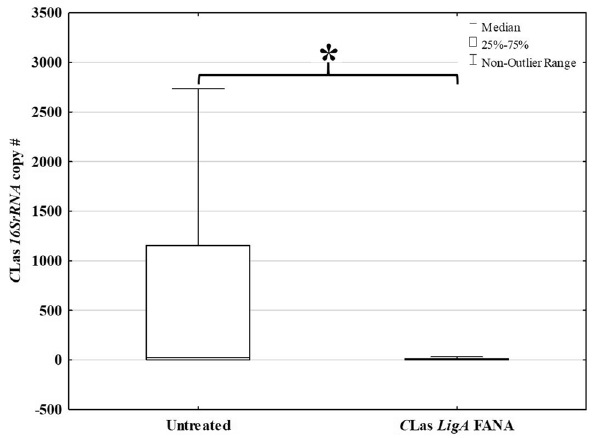
Figure 8. C Las titer detected in Citrus macrophylla seedlings following exposure to untreated or FANA-treated infected adult D. citri . Statistical differences between the treatments are designated by *( P ≤ 0.05) (TIBCO Statistica, v. 13.3.0: https ://www.tibco .com/produ cts/data-scien